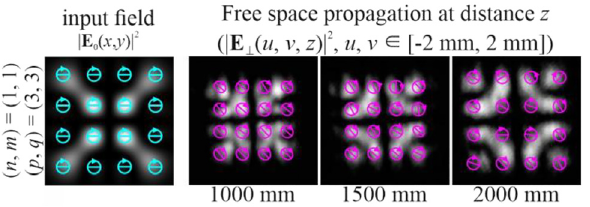
Figure 10: Experimental results for a “ + ” -circular polarization two- mode HG beam de fi ned by Eq. (26) with indices ( n + m ) ≠ ( p + q ).